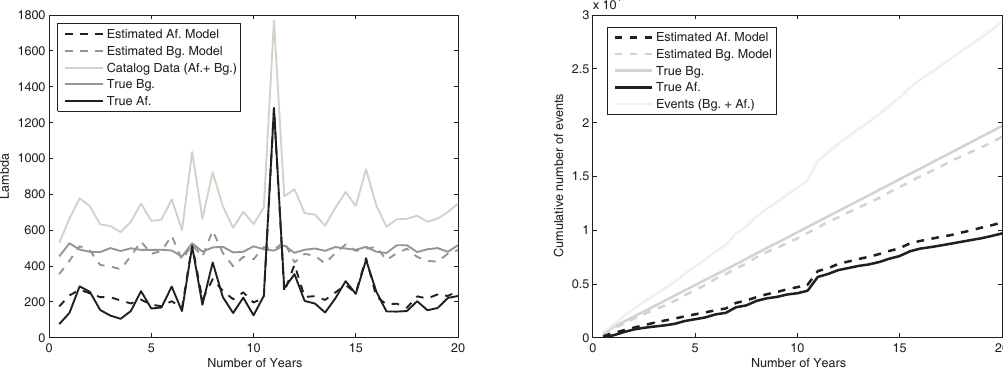
Estimated Af. Model Estimated Bg. Model True Bg. True Af. Events (Bg. + Af.)